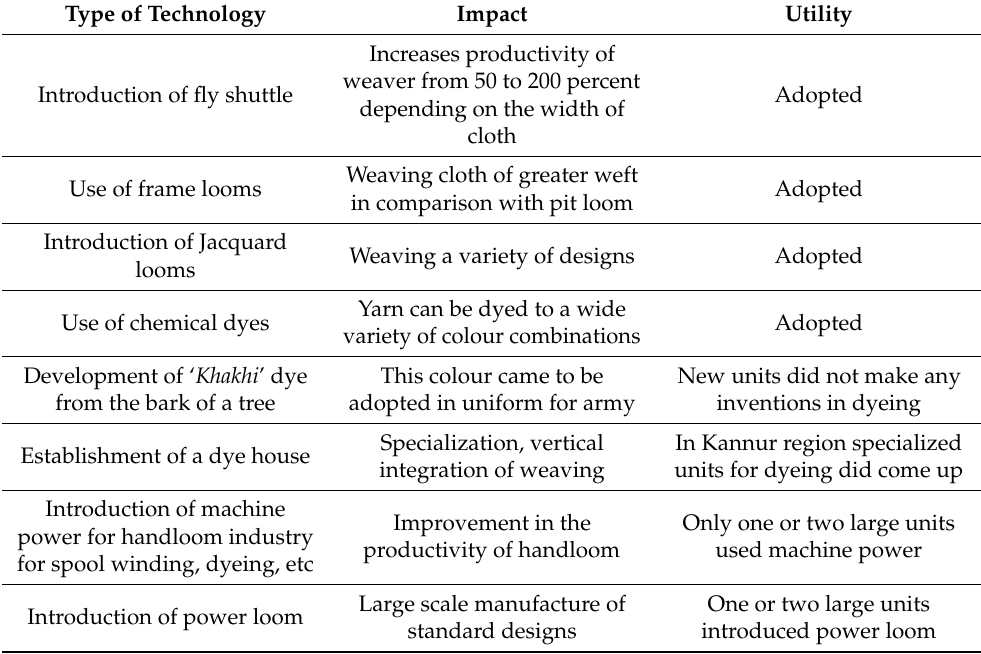
Table 2. Technologies imparted by the Basel Mission